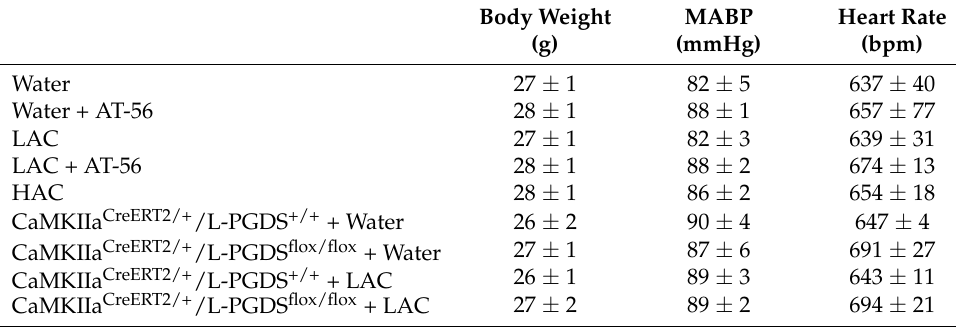
Table 1. Physiological parameters.